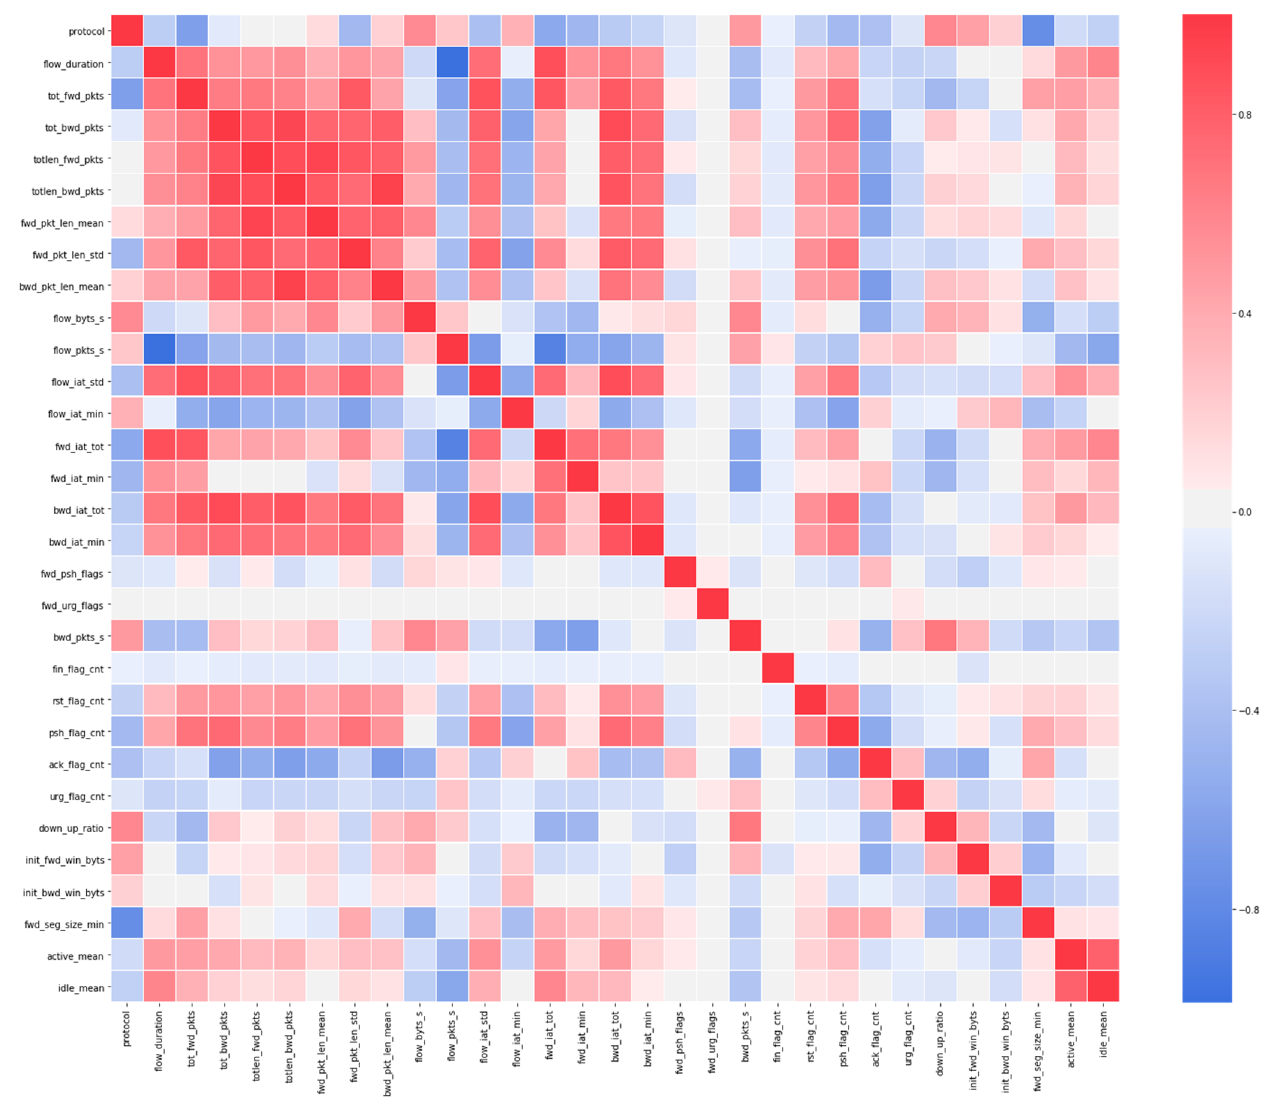
Figure 6. Correlation heatmap after the removal of highly correlated features. Table 1. Results for training dataset.